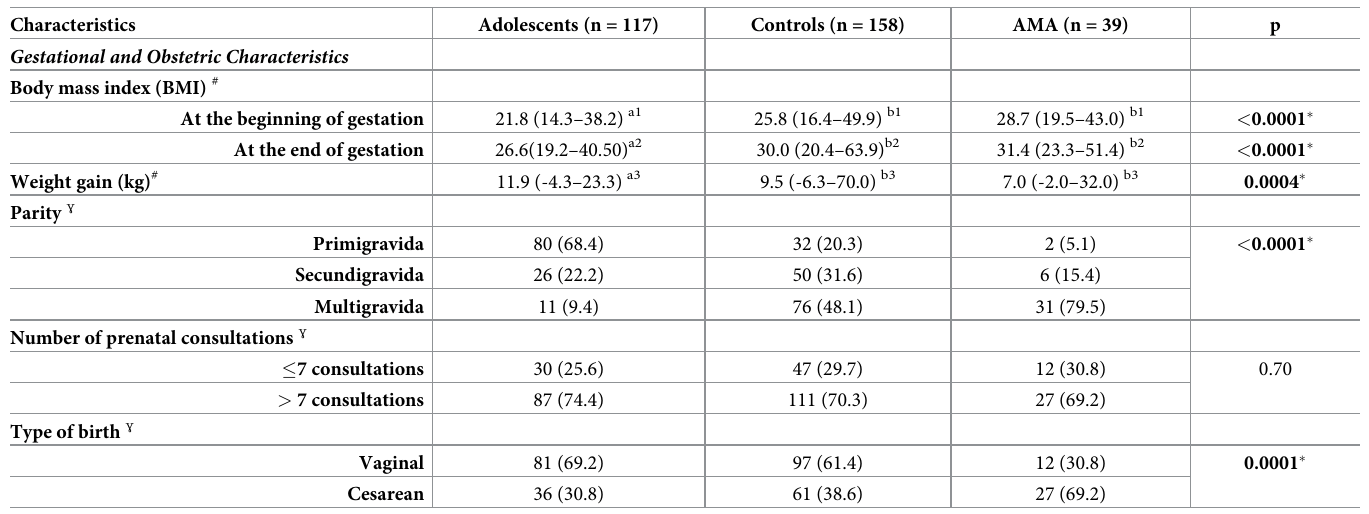
Table 2. Gestational and obstetric characteristics of adolescent, control and advanced maternal age nursing mothers included in the study.